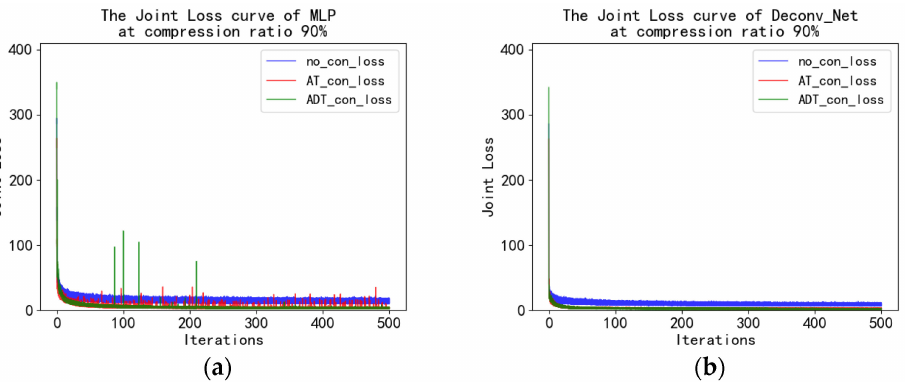
Figure 10. The joint loss curve with the end-to-end MLP model ( a ) and with the end-to-end De- conv_Net model ( b ) at a 90% compression ratio.